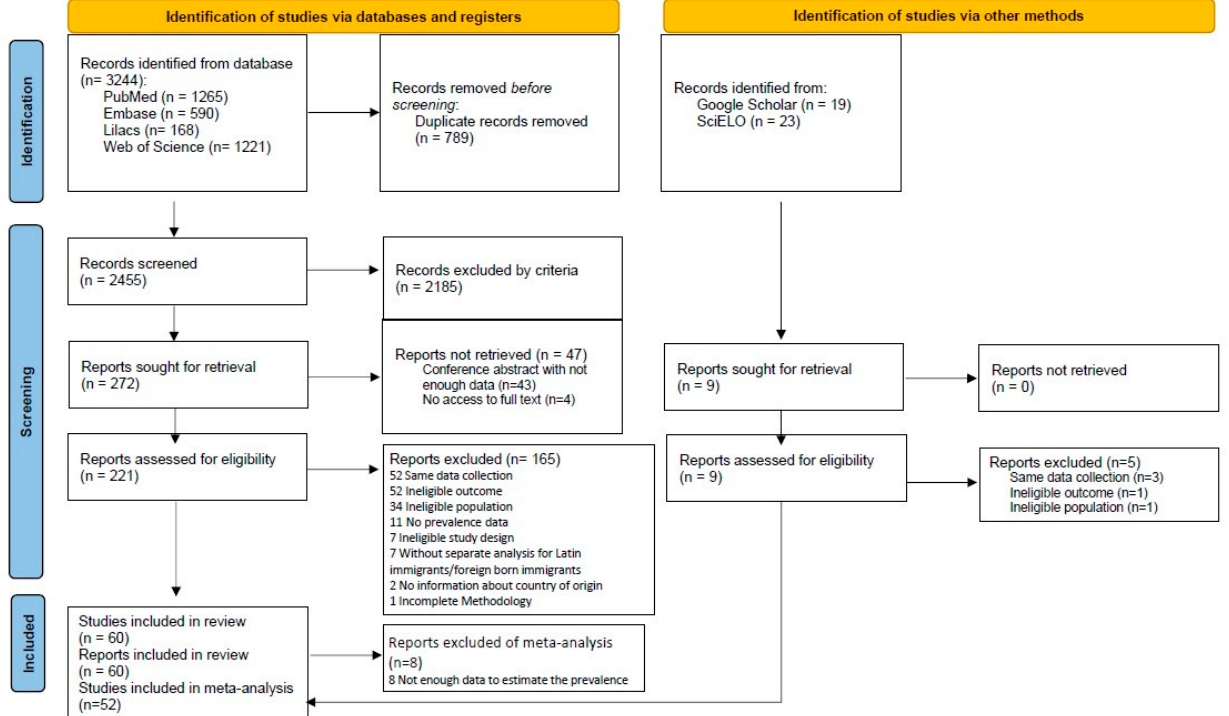
Figure 1. Flow diagram of study selection process following the PRISMA 2020 flow diagram for new systematic reviews which included searches of databases, registers and other sources. Source: model extracted from Page et al. [21].